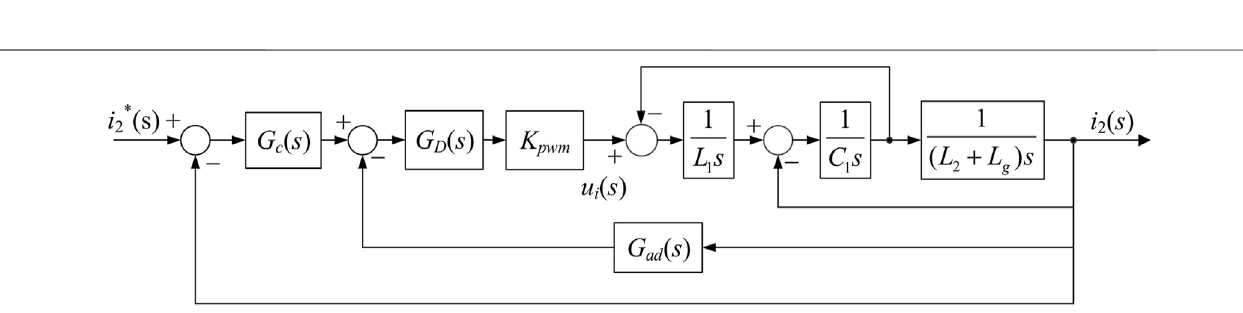
FIGURE 1 | Main circuit diagram of the three-phase LCL- fi ltered grid-connected inverter.